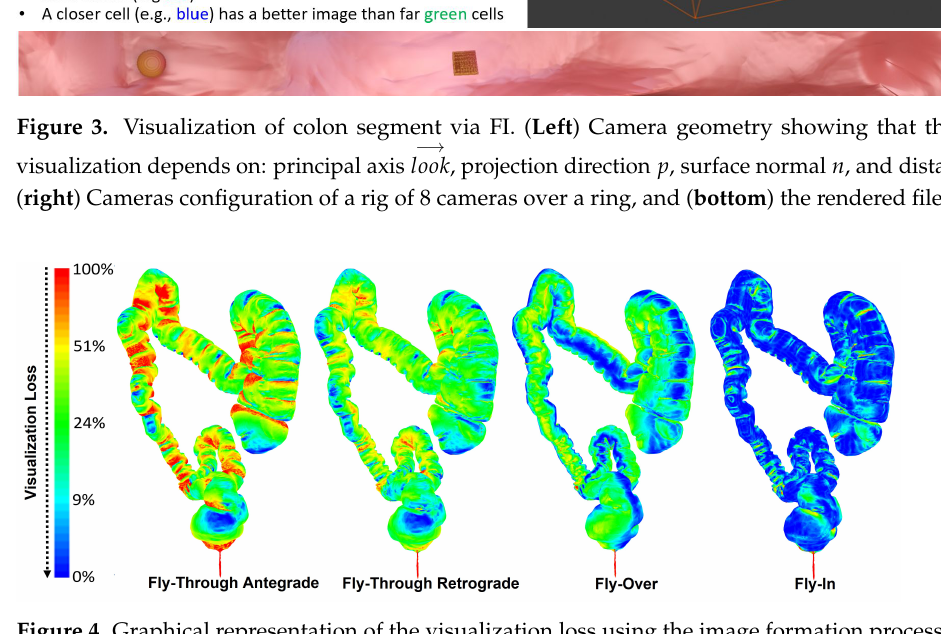
Figure 4. Graphical representation of the visualization loss using the image formation process in FT (both directions), FO, and